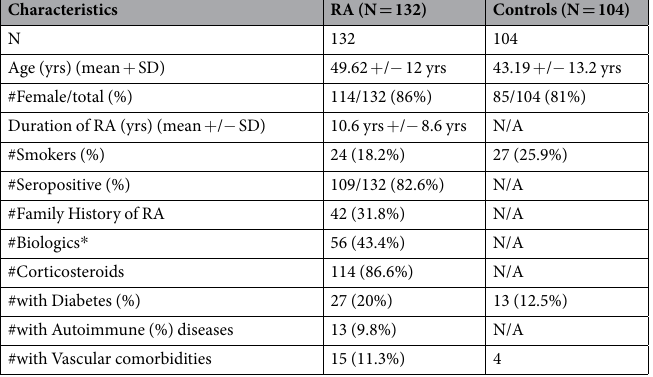
Table 1. Subject Characteristics. * Biologics include anti-TNF therapy or Rituximab. N/A indicates not applicable. Smokers indicate current smokers or ever